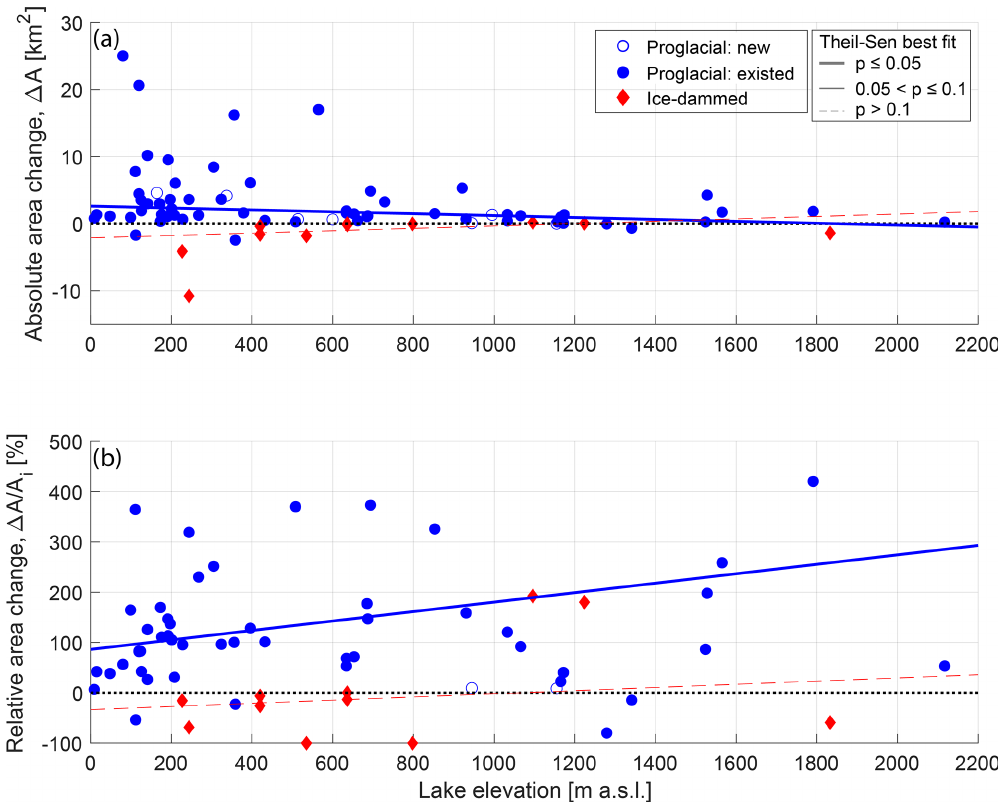
Figure 8. (a) Absolute and (b) relative lake area change as a function of lake elevation for proglacial (blue circle) and ice-dammed (red diamond) lakes. On both panels, lines show the linear fit to proglacial (blue) and ice-dammed (red) lakes as estimated by the non-parametric Theil–Sen robust line. Thick solid lines show relationships that are significant at the p ≤ 0 . 05 level; thin solid lines show 0 . 05 < p ≤ 0 . 1 relationships, and thin dashed lines show p > 0 . 1 relationships. All significance values are estimated by the Kendall rank correlation test. The dotted black line shows zero lake area change. Unfilled symbols indicate lakes that appeared during the study